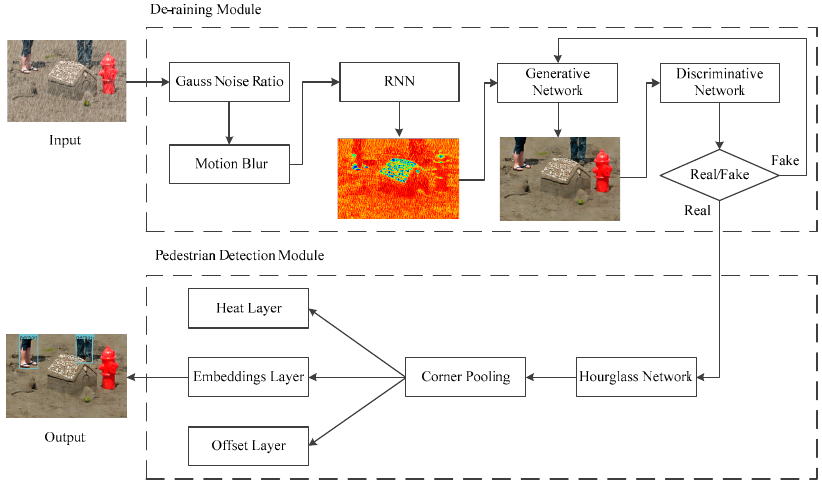
Figure 1. Architecture of the proposed algorithm.